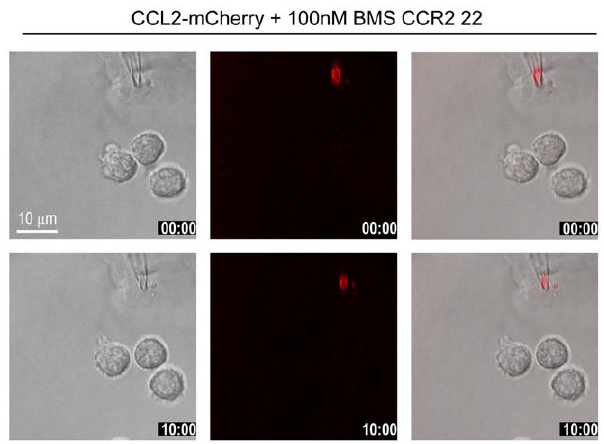
Figure 5. CCL2-mCherry uptake is blocked in the presence of an CCR2 antagonist. Selected frames from time-lapse video microscopy (Movie S6) of human monocytes recorded at 37 u C in the presence of 100 nM of the CCR2 antagonist BMS CCR2 22. The micropipette was dispending 100 nM CCL2-mCherry with constant backpressure. Left panels phase images, middle panels CCL2-mCherry (ex 594 nm/em 620–680 nm), and right overlay. Time stamps are indicated in mm:ss.